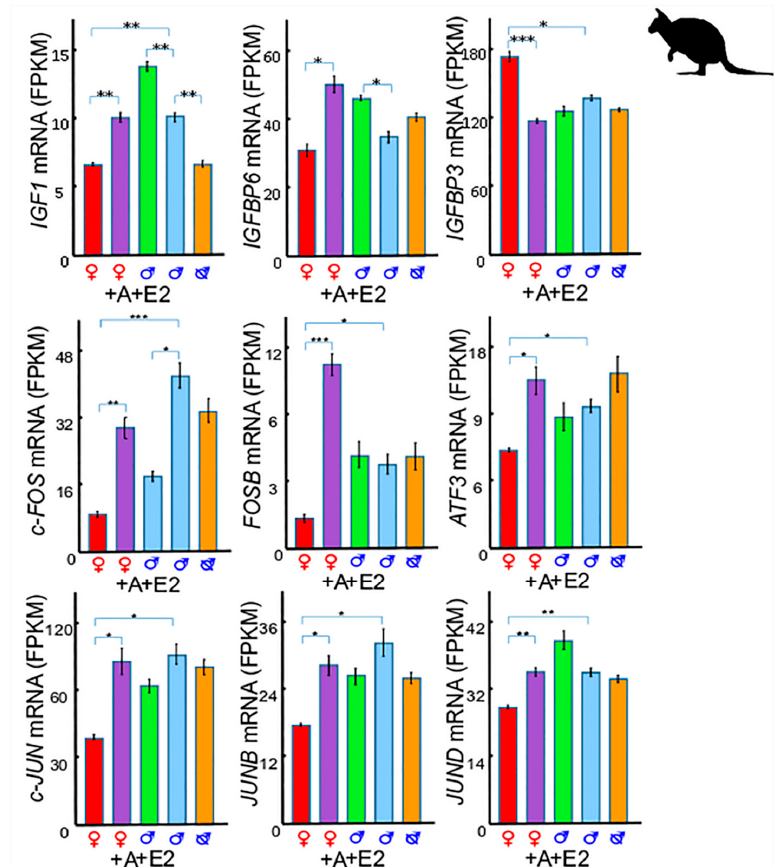
Figure 3. Gene expression of IGF1 , IGFBP3 , IGFBP6 , and Activator Protein 1 (AP-1) genes in